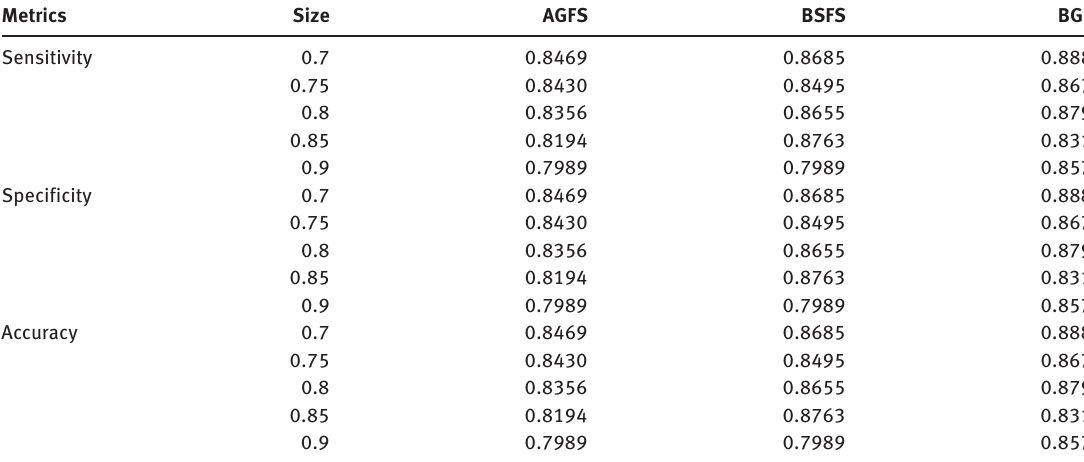
Table 4: Comparison on Cleveland.